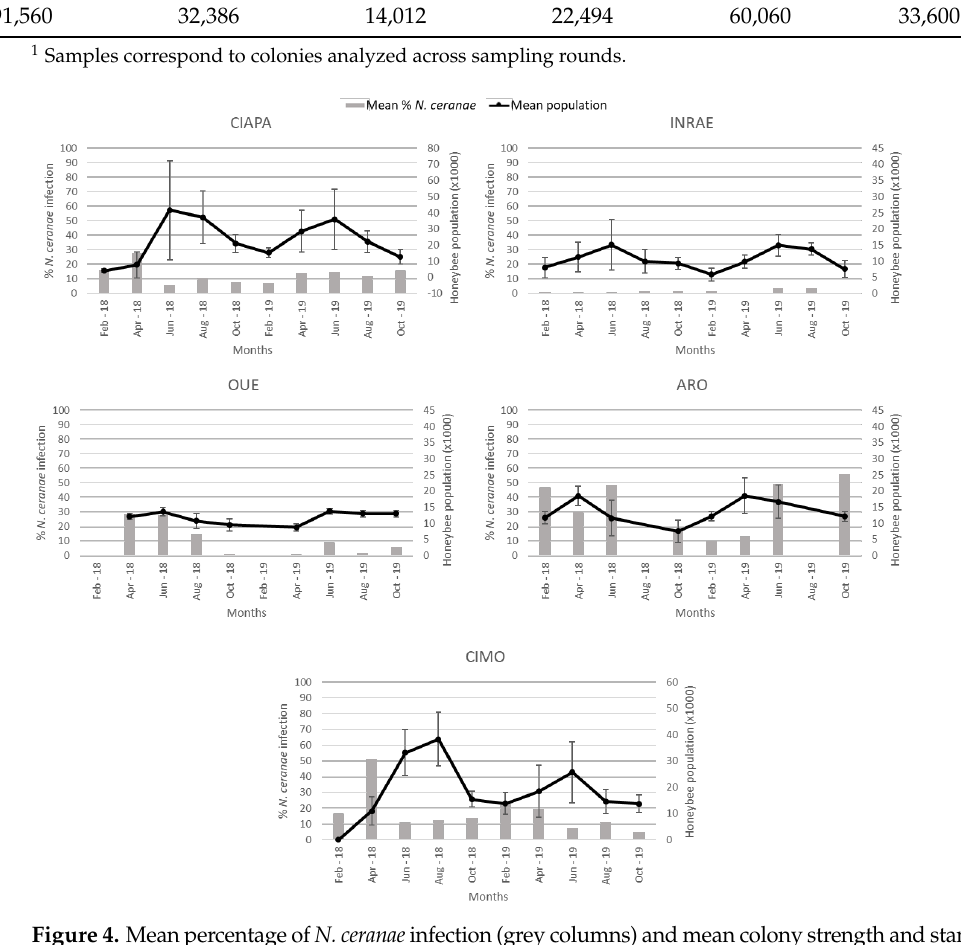
Figure 4. Mean percentage of N. ceranae infection (grey columns) and mean colony strength and standard deviation (black line) per apiary during the study period. Colony strength is represented in number of honeybees (thousands). In OUE and ARO, there was no data collection in February and August, respectively, due to weather conditions. Colony strength, estimated at each sampling round, was analyzed to determine if there was a relationship with the percentage of honey bees infected by N. ceranae (Figure 4). When the data generated for each apiary were analyzed altogether, there was a positive correlation (r = 0.179) between the two variables (Spearman’s Rho; p < 0.0001). However, when the analysis was done individually for each apiary, a different pattern was ob- served. While in the CIAPA and CIMO apiaries, a significant negative correlation (r = − 0.299 and r = − 0.257, respectively) between the percentage of N. ceranae infection and col- ony strength was observed (Spearman’s Rho; p < 0.01), and in INRAE and OUE, the cor- relation was positive (Spearman Rho; r = 0.252 and r = 0.299, respectively; p < 0.01). In ARO, the correlation was not significant, although the trend was negative as in CIAPA and CIMO (Spearman’s Rho; p > 0.05). SMI was not included in the analysis because N. ceranae was not detected in any colony across time.